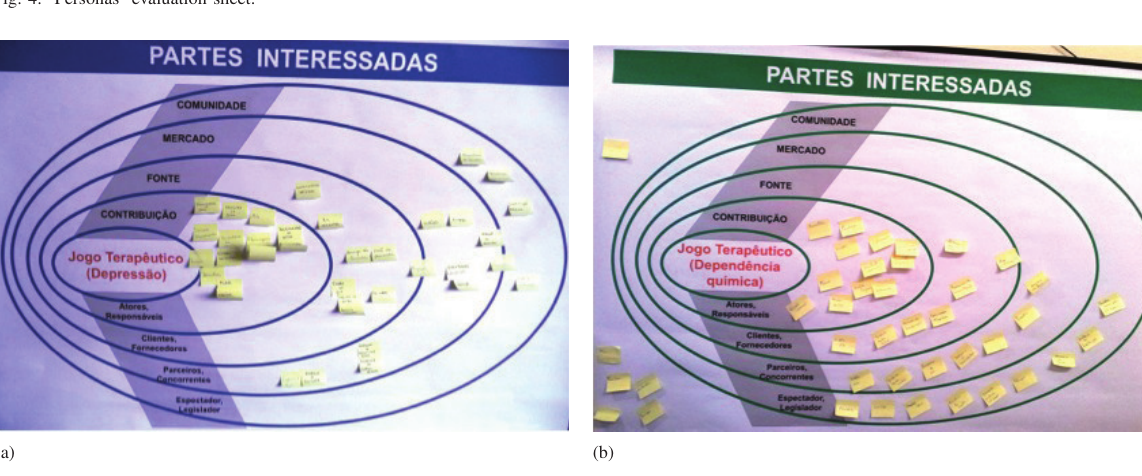
Fig. 5. Stakeholders for the therapeutic games intended to depressive patients (a) and to chemical addicts (b).